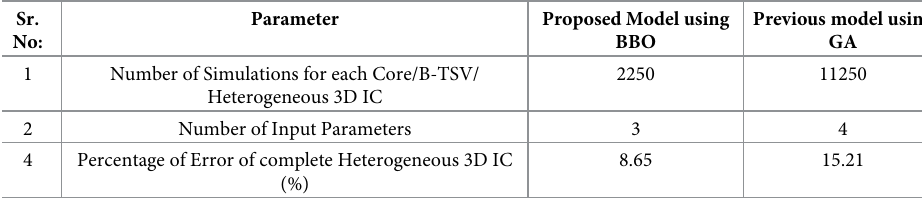
Table 9. Comparison with previous model. Sr.